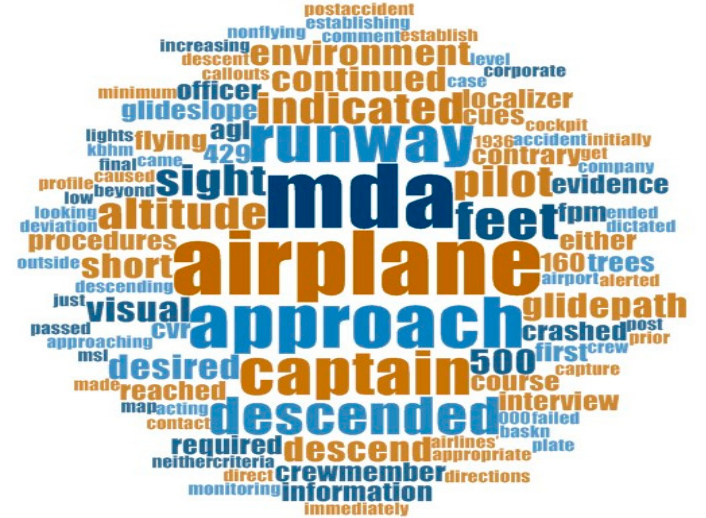
Figure 7. Word frequency tag cloud for Unauthorized Descent Below an IFR Altitude.